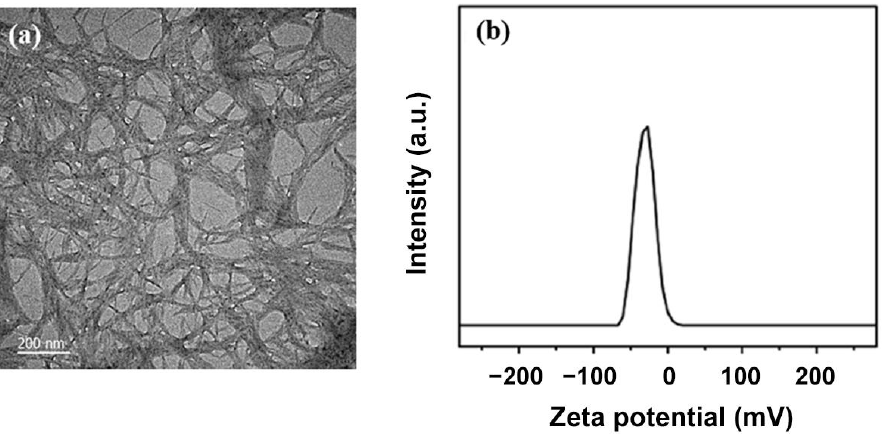
Figure 1. ( a ) TEM image of the as-prepared CNC; ( b ) Zeta potential of the CNC